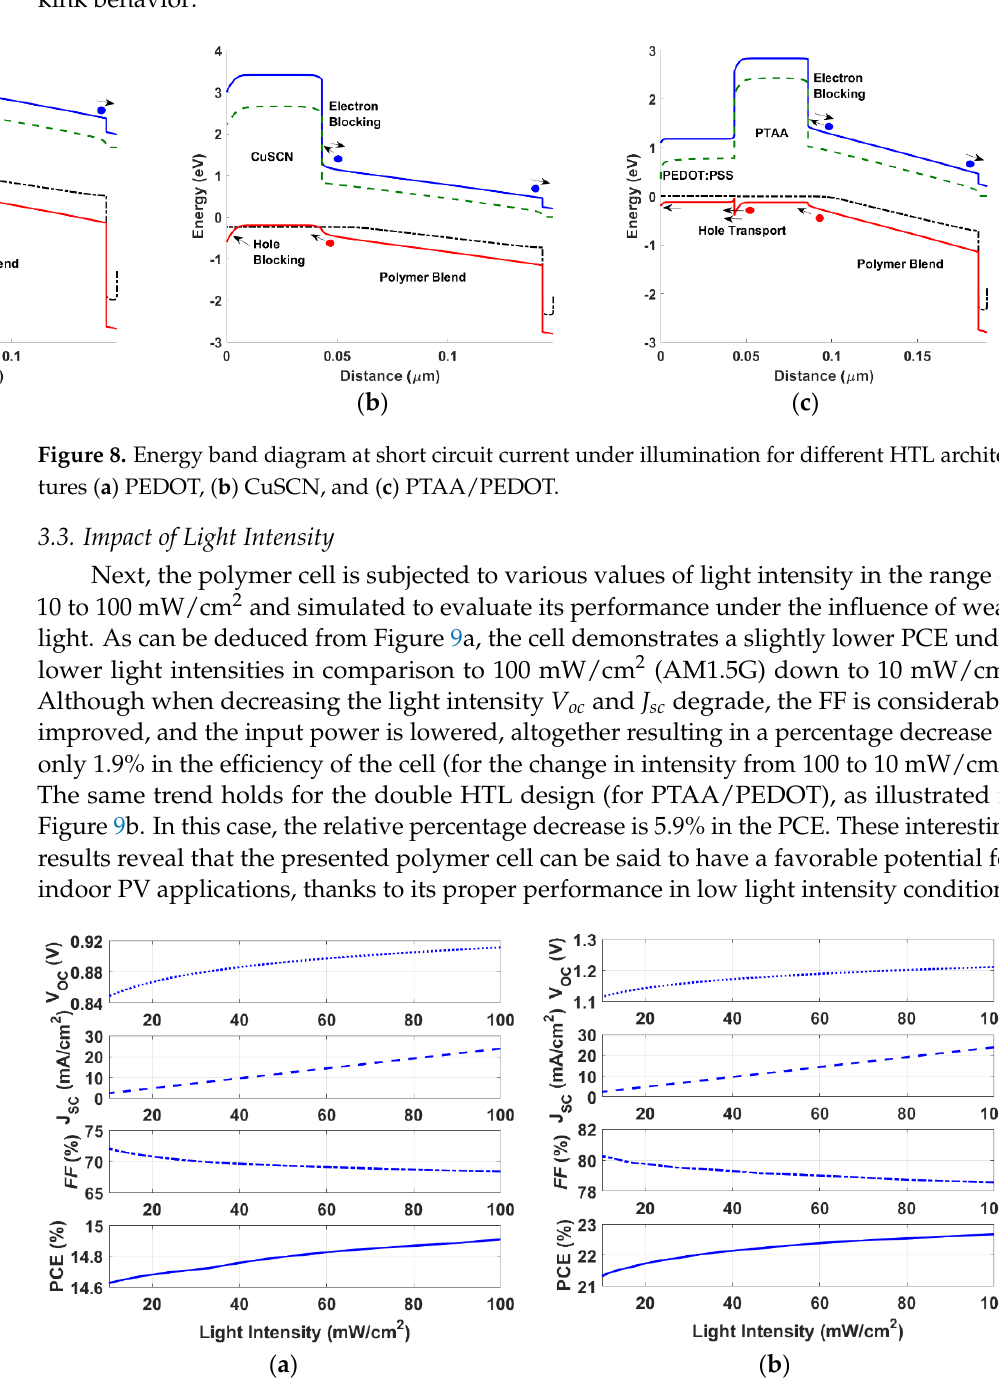
Figure 9. Variation of optoelectronic parameters according to the change in light intensity ( a ) initial PEDOT single HTL cell, and ( b ) PTAA/PEDOT double HTL.